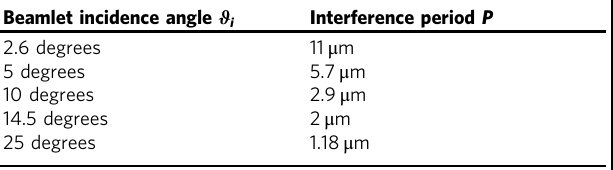
Table 1 List of beamlets incidence angle ϑ i and correspondent value of